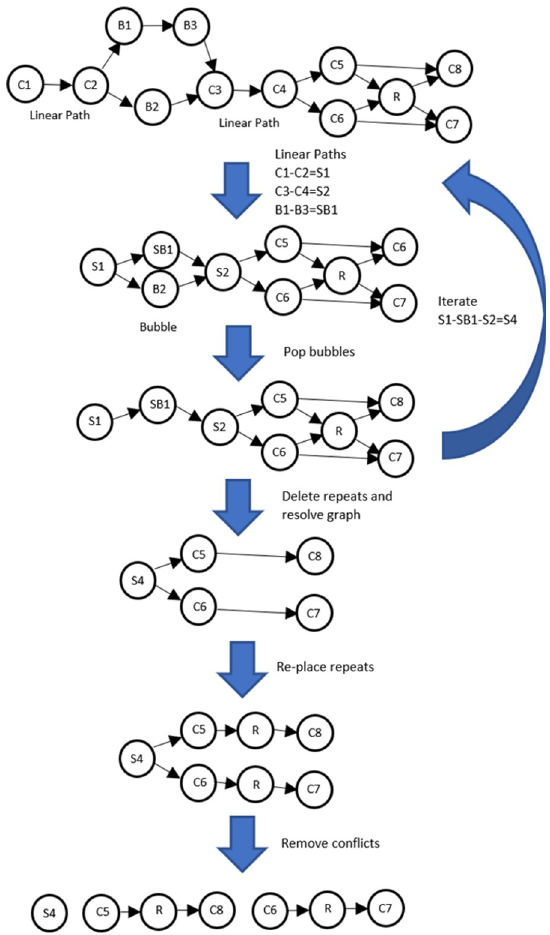
Fig 3. Overview of the SAMBA scaffolding algorithm. The method resolves the initial graph into three final contigs, C1-C2-B1-B3-C3-C4 (S4), C5-R-C8 and C6-R-C7. The repeat contig R is duplicated in the final output. Note that if there were no proper edge between contigs C5 and C8, then the final output would contain C5 and C8 standalone instead of C5-R-C8.